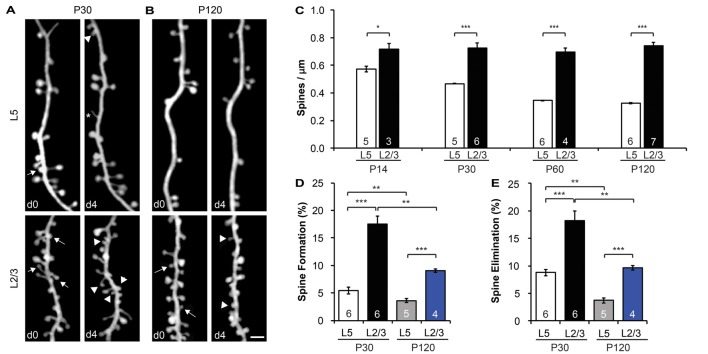
L2/3 PNs have higher spine density and dynamics than L5 PNs. (A,B) Repeated imaging of the same dendritic branches over 4-day intervals in the motor cortex of adolescent (P30) (A) and adult (P120) (B) mice. Arrows indicate eliminated spines, and arrowheads indicate newly formed spines. Filopodia are labeled by asterisks. Scale bar: 2 μm. (C) The spine density of L5 PNs undergoes a developmental decrease, whereas the spine density of L2/3 PNs remains constant from adolescence to adulthood. (D,E) Apical dendrites of L2/3 PNs display higher formation (D) and elimination (E) rates than L5 PNs in both adolescent and adult mice. Kruskal-Wallis rank sum test followed by post hoc multiple comparison was used for statistical analysis. *p < 0.05, **p < 0.01, ***p < 0.001. All data are presented as mean ± SEM. Numbers of mice analyzed are indicated in the figure.